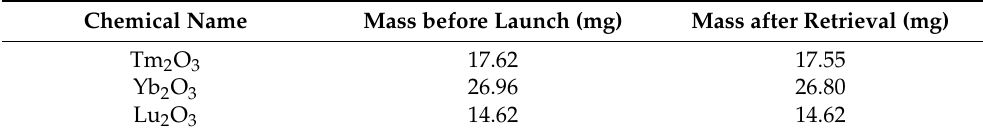
Figure 5. Measured densities of molten Ln 2 O 3 vs. temperature with 2.5% error bars: ( a ) Tm 2 O 3 ; ( b ) Yb 2 O 3 ; ( c ) Lu 2 O 3 . The values by Granier and Heurtault are plotted with 5% error bars. Table 2. Typical sample mass before and after the flight experiments.